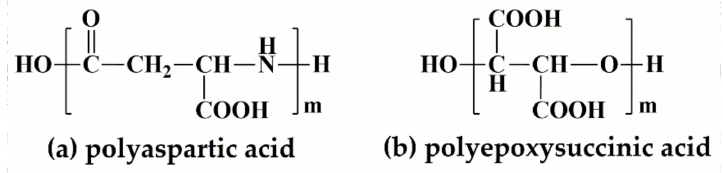
Figure 1. Molecular structures of ( a ) polyaspartic acid and ( b ) polyepoxysuccinic